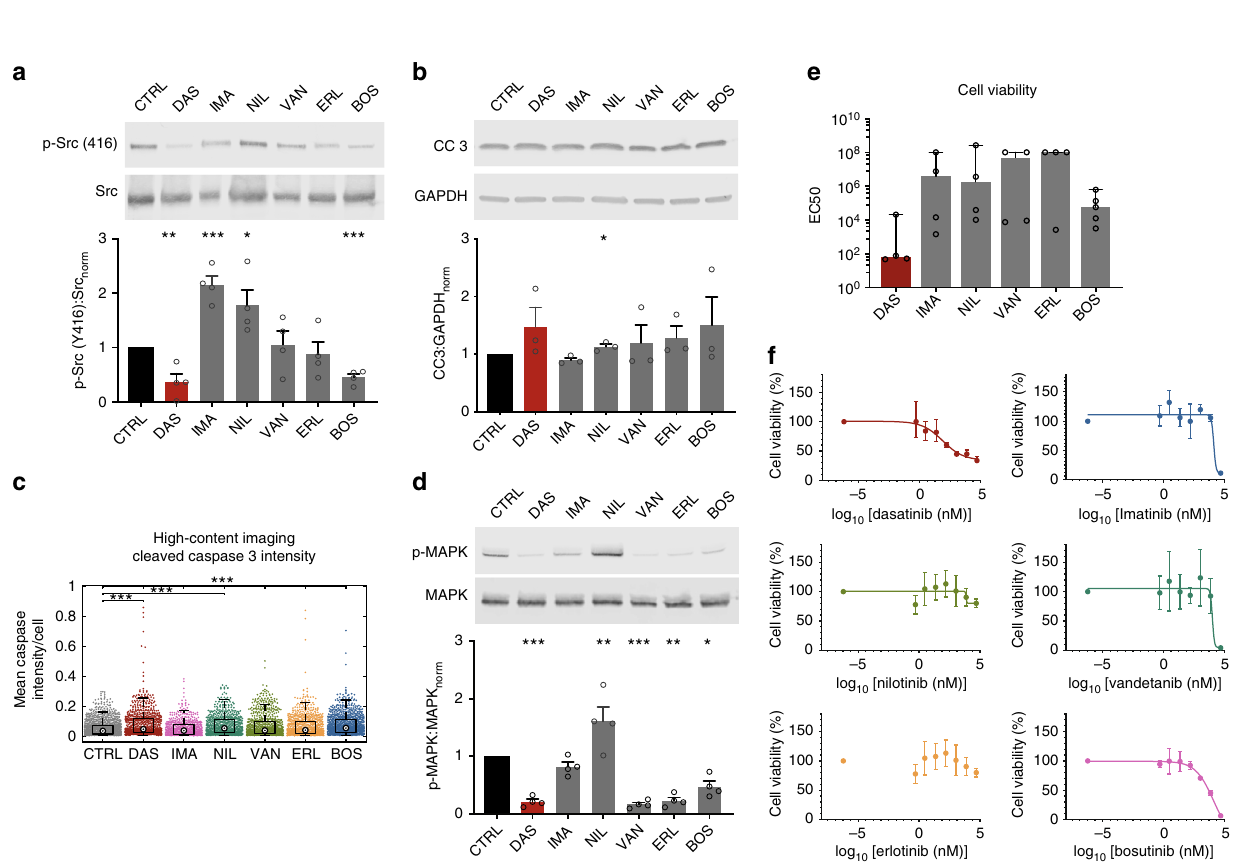
Fig. 3 Dasatinib does not have a unique effect on cell survival compared to other KIs. a Western blots for p-Src (Y416) show that both bosutinib and dasatinib at 2 µ M strongly inhibit SRC (mean ± SEM, * p < 0.05, unpaired t -test). b Western blot (mean ± SEM; * p < 0.05, unpaired t-test) and c immuno fl uorescence-based high-content image analysis (median ± middle quartiles; *** p < 0.001, Kruskal-Wallis one-way ANOVA followed by Tukey post-hoc multiple comparison) both showed small increase in apoptosis, as quanti fi ed by levels of cleaved caspase 3 (CC 3); however there were no signi fi cant differences between dasatinib and other KIs. d Western blots for p-MAPK, a key kinase for cell survival, showed that dasatinib is not unique in its ability to block this pathway (mean ± SEM; * p < 0.05, unpaired t -test). e Dasatinib had a major effect on podocyte viability after 24 h of treatment, as assessed by four-parameter half-maximal effective concentration (EC50) fi t of the MTT dose-response curve. Even though dasatinib had the lowest EC50, it was not signi fi cantly different from other KIs (geometric mean ± geometric SD, p = 0.169, Kruskal – Wallis one-way ANOVA). f Representative cell survival curves showing percent viability normalized to vehicle